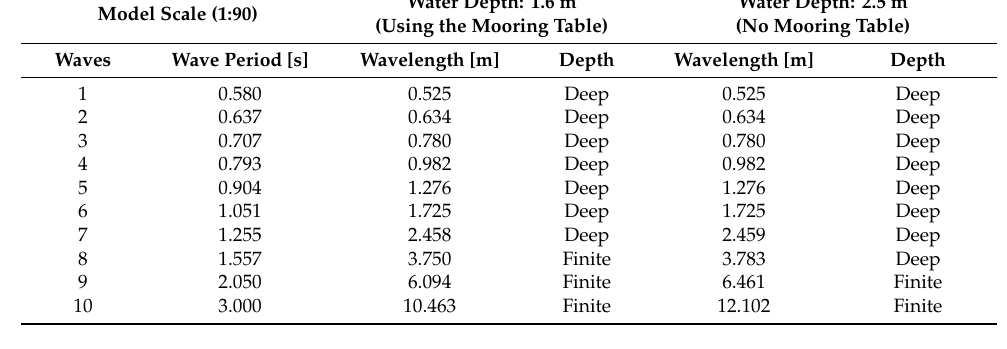
Table 5. Determining the water depths.